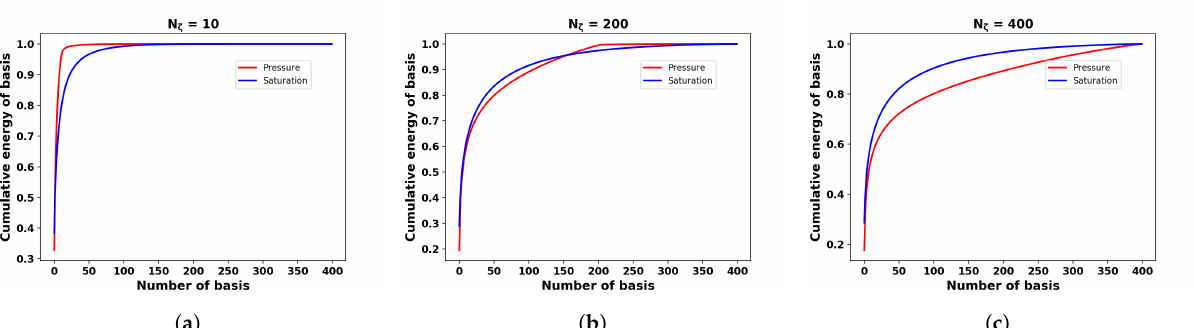
Figure 5. Change in cumulative energy of the basis, as calculated by magnitude of eigenvalues for increasing number of parameters (well configurations) ( a ) N ζ = 10, ( b ) N ζ = 200, ( c ) N ζ = 400, in the state snapshot